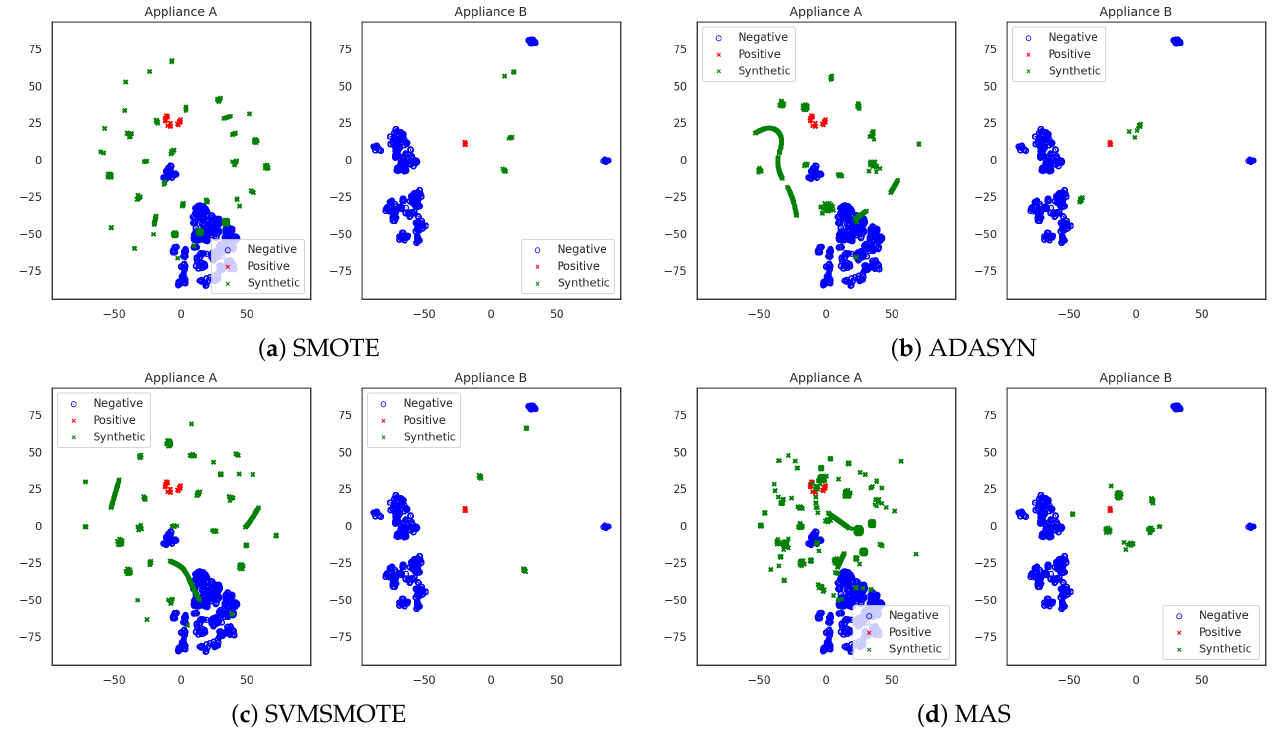
Figure 5. Visualizing positive, negative, and synthetic samples using t